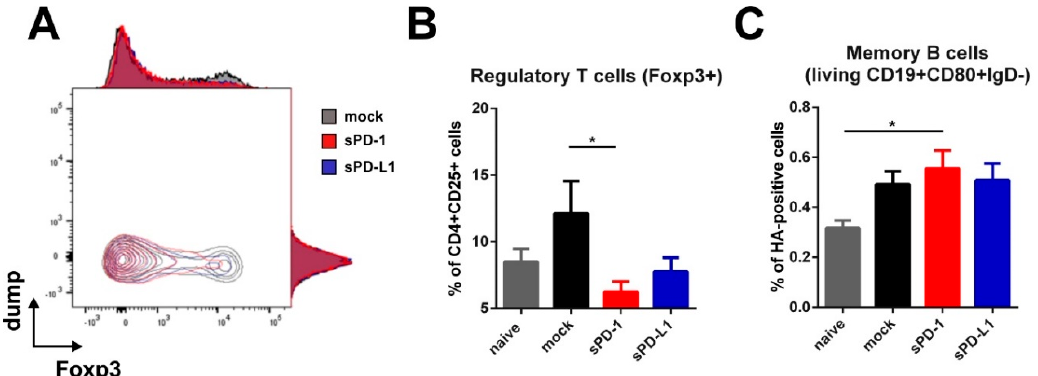
Figure 6. Regulatory T cells and memory B cells are modulated by soluble PD-1. Foxp3 expression among CD4 + CD25 + T cells shown as overlaying blots and histograms ( A ) and percentage of Foxp3-expressing regulatory T cells (within living CD4 + CD25 + cells) ( B ) in the spleen of BALB / c mice 20 weeks after boosting. Shown are mean values with SEM ( n = 18) and significant di ff erences between groups (one-way ANOVA analyses followed by Tukey’s multiple comparison test, * p < 0.05). ( C ) Frequency of HA-specific memory B cells (living CD19 + CD80 + IgD-HA + ) in the spleens of BALB / c mice 20 weeks after boosting. Shown are mean values with SEM ( n = 12) and significant di ff erences between groups (one-way ANOVA analyses followed by Tukey’s multiple comparison test, * p <